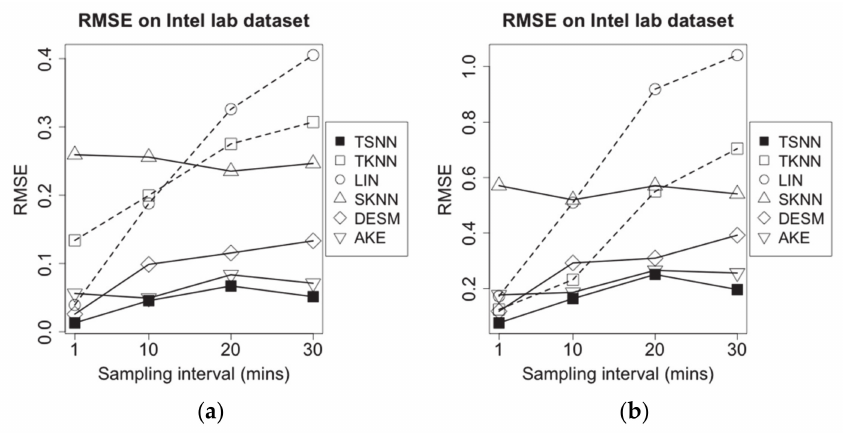
Figure 9. RMSE of imputation algorithms on different data density for Intel lab dataset: ( a ) tempera- ture data and ( b ) humidity